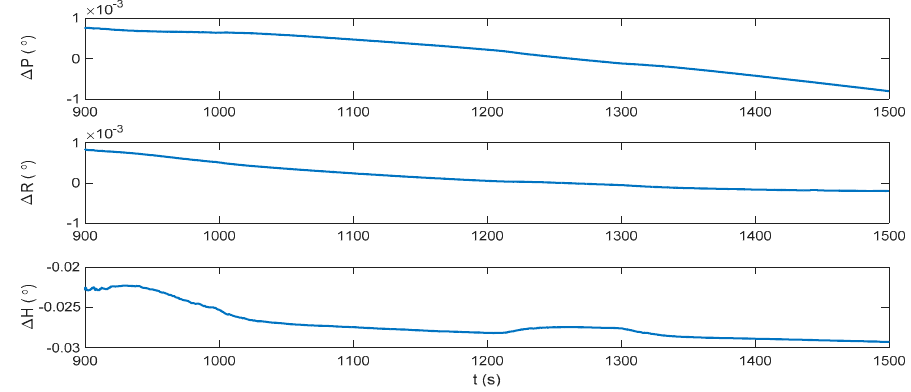
Figure 13. Attitude error of the pure INS solution during the DVL outage.